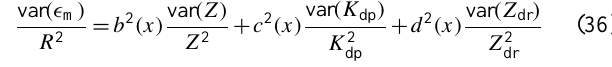
Fig. 4. Estimated versus exact rain rate. (a) R(Z) , (b) R(Z,Z dr ) , (c) R(K dp ) , (d) R(K dp ,Z dr ) , (e) R(Z,K dp ,Z dr ) .